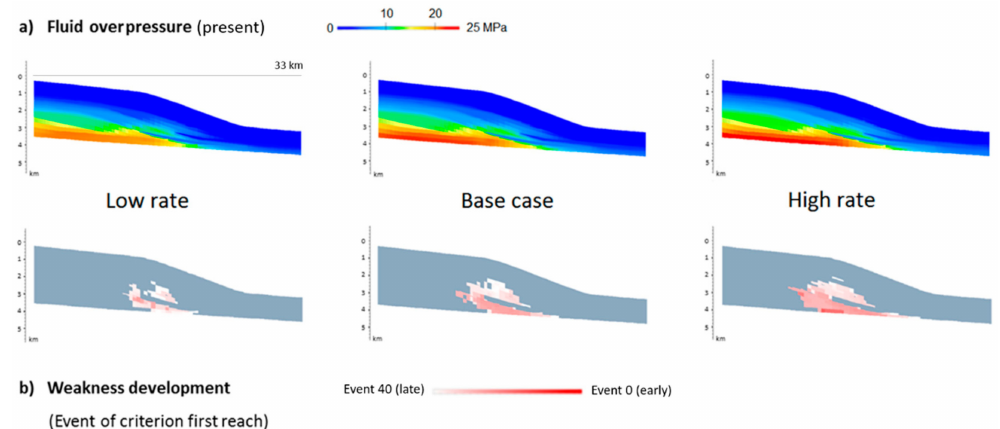
Figure 7. Influence of sedimentation rate on weakness development: globally. ( a ) present-day fluid overpressure simulated on the three scenarios; ( b ) event of criterion first reach in the three scenarios: the stronger the red color, the earlier the area becomes weak; vertical exaggeration ×